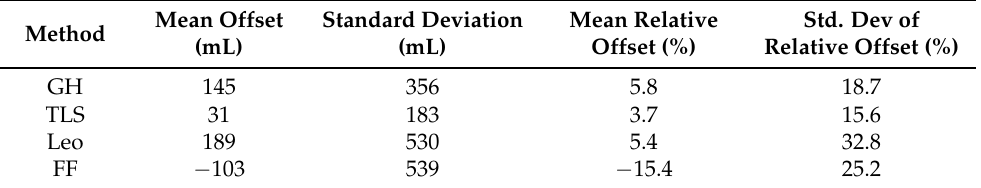
Figure 12. Point clouds of defect 27 (plot 7), colored based on vertical distance to nearest point in Nikon point cloud. Table 14. Offsets and standard deviation of offsets of defect volumes compared to volume measured from Nikon point cloud.